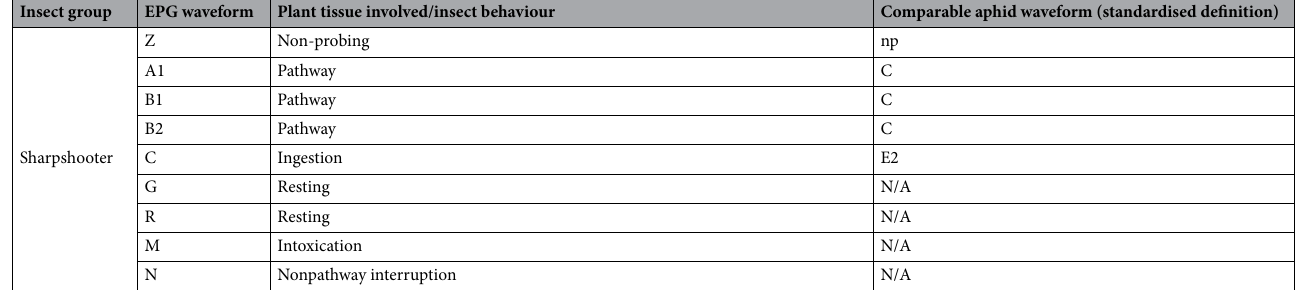
Table 2. Common codes used to normalise the variation within EPG waveform nomenclature. All EPG waveform codes were coded to follow the standard aphid EPG codes. Psyllid EPG groupings were described in 51 Chinch bug waveform descriptions followed 52 , Leafhopper characterisation 53 , planthopper characterisations 54 , whitefly characterisations 55 , and sharpshooter characterisation 56 . Note that for the sharpshooter studies xylem ingestion was coded as E2 to represent ingestion of the primary plant sap these insects feed from. N/A denotes species-specific waveforms where there is no comparable aphid